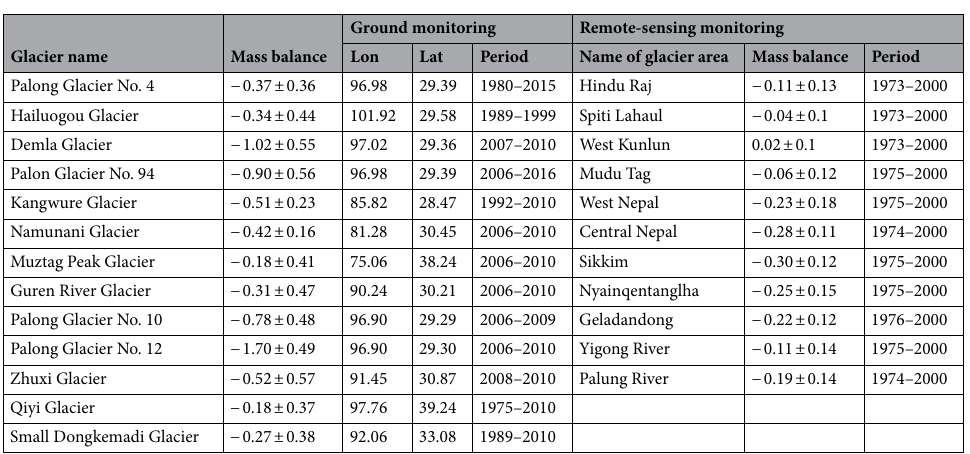
Figure 5. Time ( a ) and space ( b ) difference of recorded mass balance of typical temperate glaciers. (The triangle and circle in the bottom figure indicate glacier mass balance based on ground observation and remote-sensing monitoring, respectively.). ( a ) Created by Origin Pro 8 SR0 v8.0724 (b724) (www.Origi nLab.com); ( b ) Created by ArcMap version 10.2 (http://deskt op.arcgi s.com/en/arcma p/).